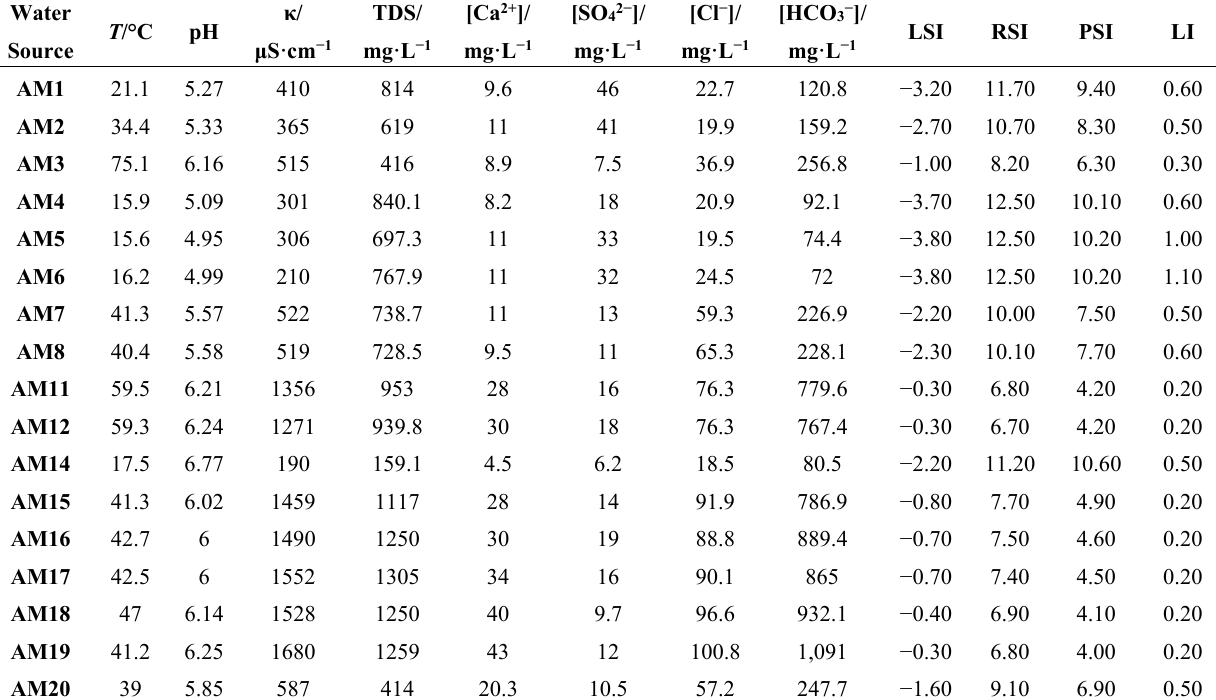
Table 2. Temperature, pH, conductivity ( κ ), total dissolved solids (TDS) and major element composition of mineral water from spring (spr) discharges in the Azores archipelago according to Cruz et al. [16]. Calculation of the corresponding stability and scaling indexes, namely the Langelier Saturation Index (LSI), Ryznar Stability Index (RSI), Puckorius Scaling Index (PSI), and the Larson–Skold Index